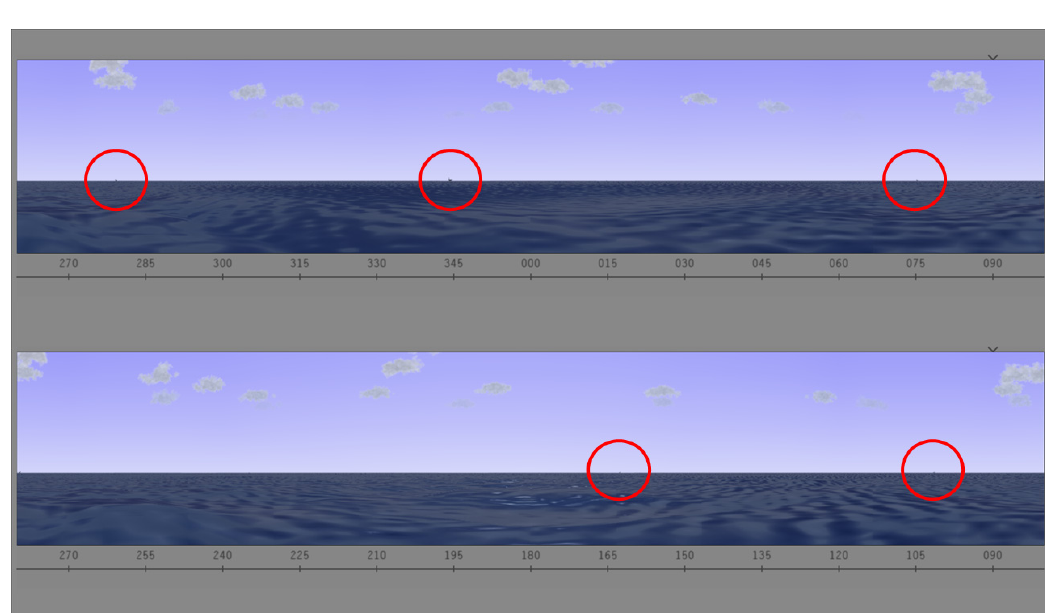
Figure 1. Ship search task. There are five ships in the screen.